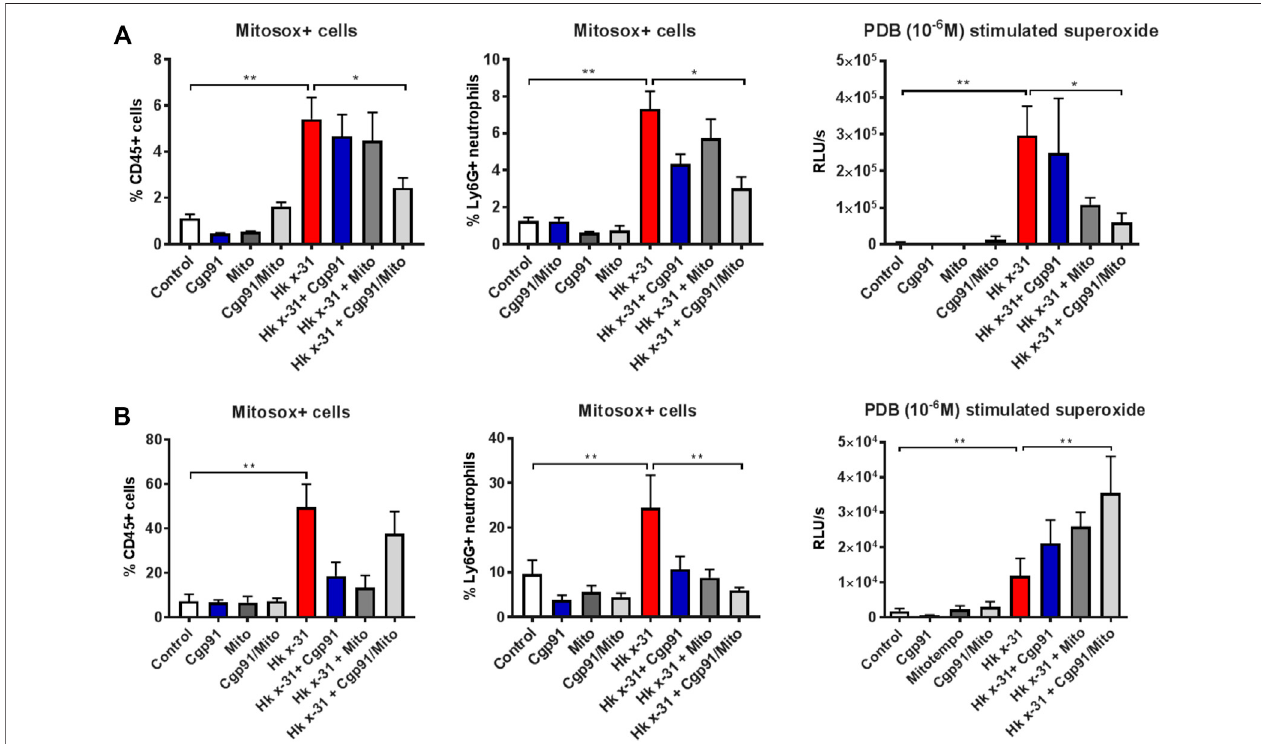
FIGURE 3 | Effects of ROS inhibition on mitochondrial and NOX2-derived ROS generation. C57Bl/6J mice were treated once daily via intranasal administration of Cgp91ds-TAT (0.2 mg/kg) and mitoTEMPO (100 µg) in combination or individually over a 2 days period 1 day pi with Hkx31 (10 4 PFUs) or PBS for assessment at (A) day 3 pi and (B) day 6 pi. Cells isolated from lung tissue were collected for mitochondrial ROS measurements by staining cells with a fl uorescent probe (Mitosox) and assesed using fl ow cytometric analysis. The populations are measured as a % of mitosox positive cells gated from the CD45 + population. The percentage of Mitosox + cells were further characterised in Ly6G + neutrophils by gating from the CD45 + population. PDB (10 − 6 M) stimulated ROS production that was quanti fi ed by L-O12 enhancedchemiluminescencefrom BALF in fl ammatory cells. Data are expressed as mean ± SEM(Control, n = 6; Cgp91, n = 4; mitoTEMPO n =4; Cgp91/Mito, n =6;Hkx31, n =8Hkx31+Cgp91, n =5;Hkx31+Mito, n =5;Hkx31+Cgp91/Mito, n =8).Statisticalanalysiswereconductedusingone-wayANOVAtestfollowedby Tukey ’ s post hoc test for multiple comparison test. Statistical signi fi cance was taken where p < 0.05 (* denotes p < 0.05 and ** p <